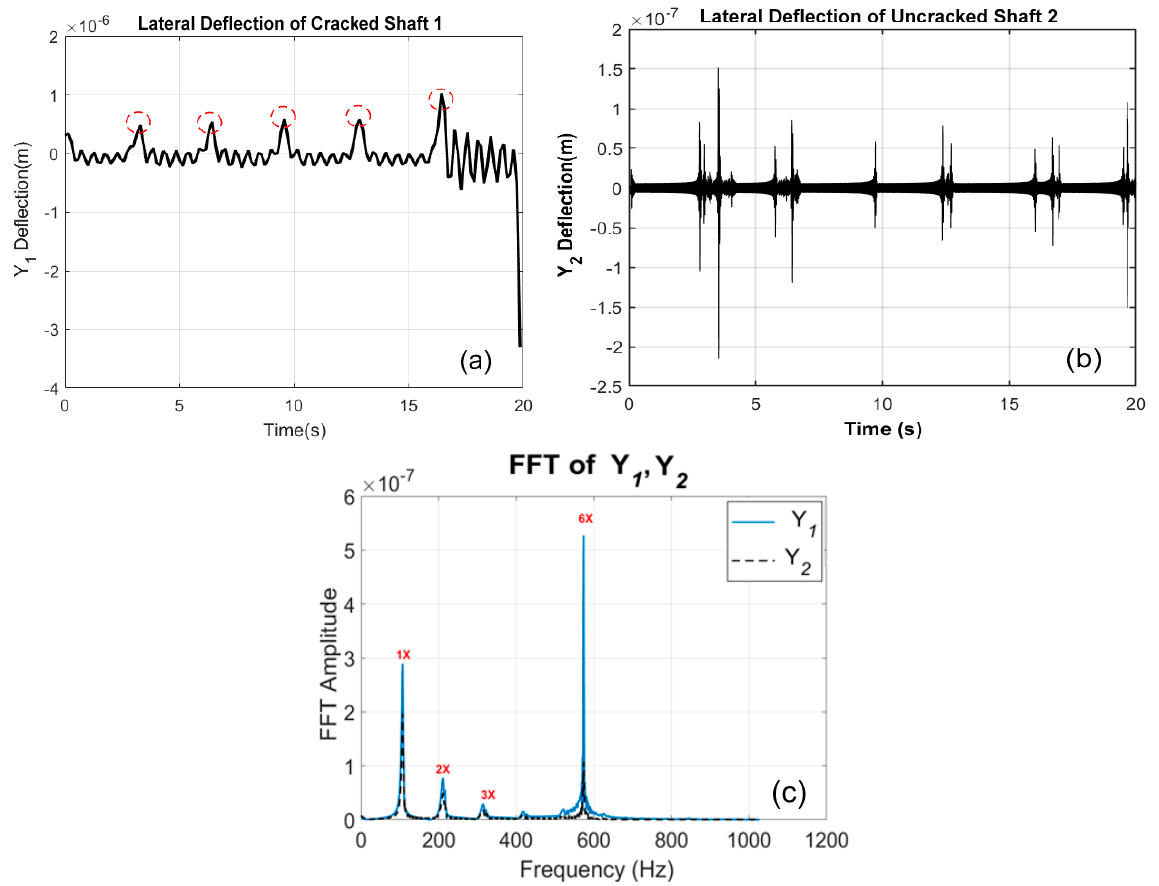
Figure 7. Simulation response of lateral vibration of the system with a crack: ( a , b ) vertical deflection of shafts 1 and 2 and ( c ) Fast Fourier Transform of shafts 1 and 2.